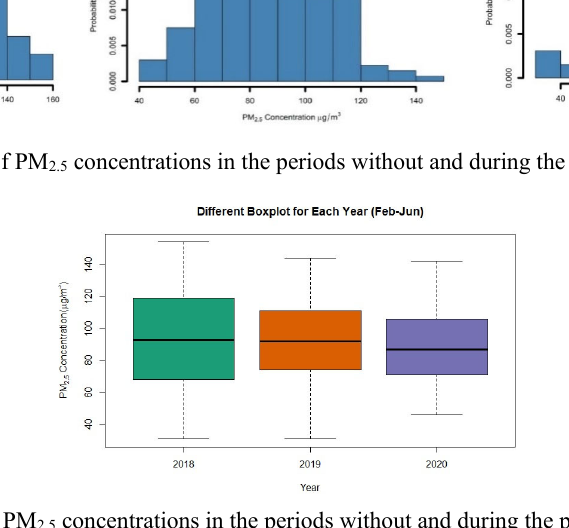
Fig. 3 . Boxplots of PM 2.5 concentrations in the periods without and during the period with COVID-19